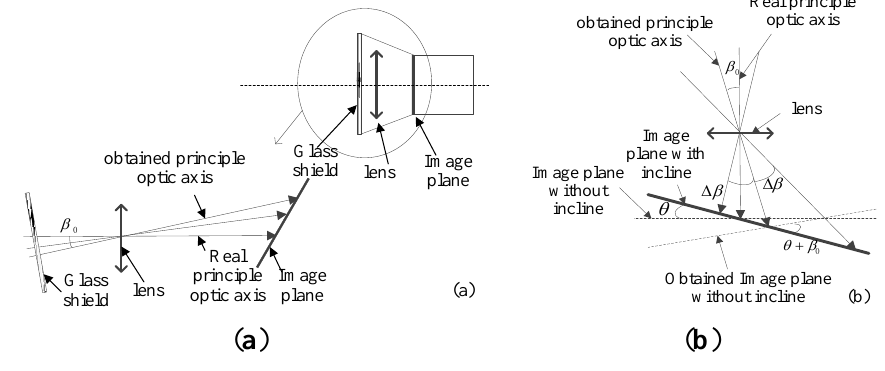
Figure 20. ( a ) Principal optic axis deviation error and its effect; ( b ) Its effect on the calibration